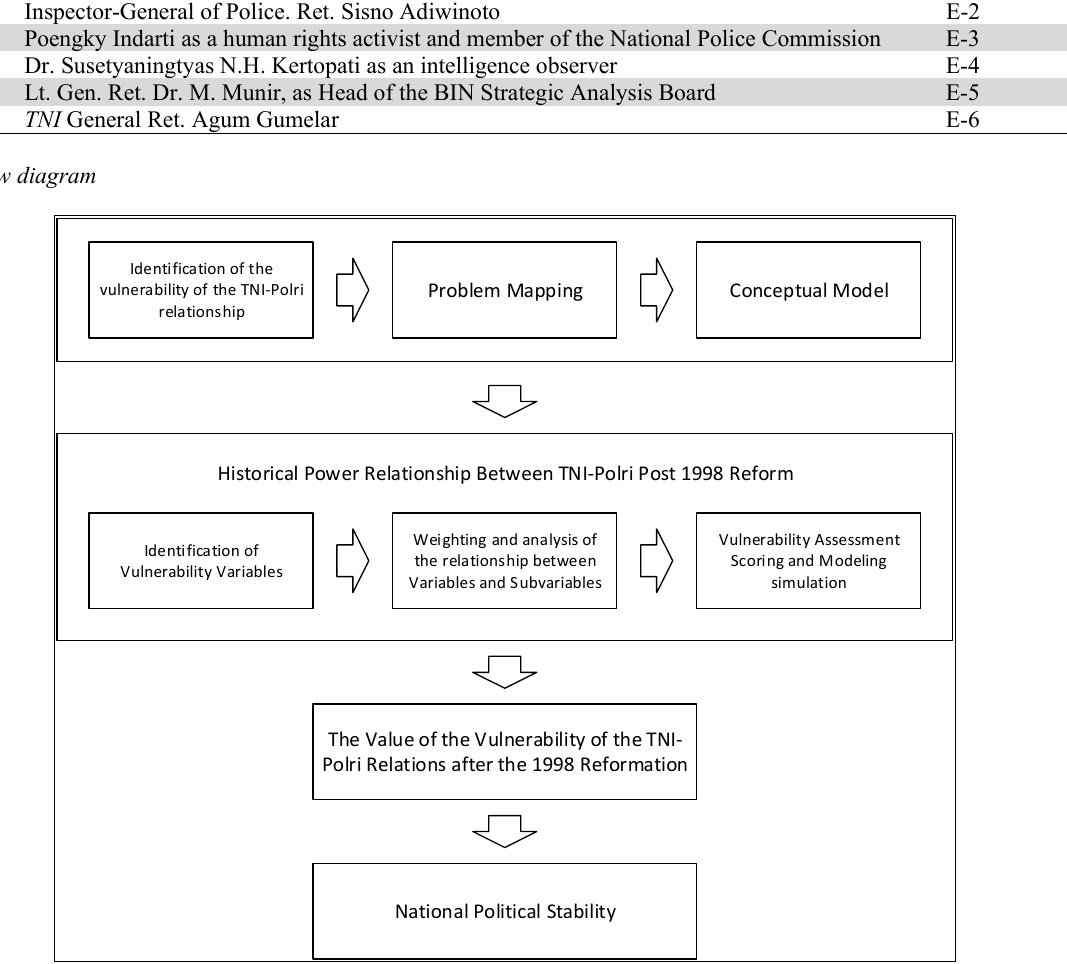
Fig. 2. Conceptual framework of the TNI-Polri power